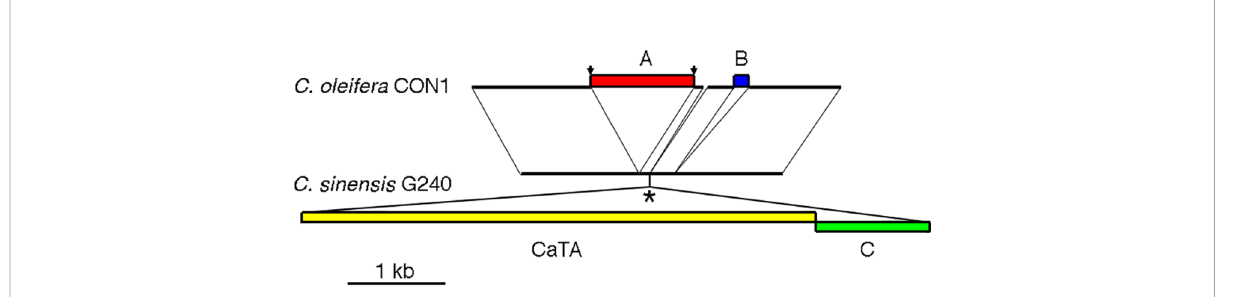
FIGURE 2 Sequence of the CaTA-less species C. oleifera isolate CON1 (top) at the CaTA insertion site of C. sinensis G240 (bottom). (A) insert in C. oleifera CON1, fl anked by inverted repeats TGCAACTAAG at its ends, and a direct repeat of the original target sequence GTCCAGCT (arrows). (B) insert in C. oleifera . *: putative site of insertion of the C. sinensis G240 CaTA insert ligated to an adjacent plant sequence (indicated by (C)